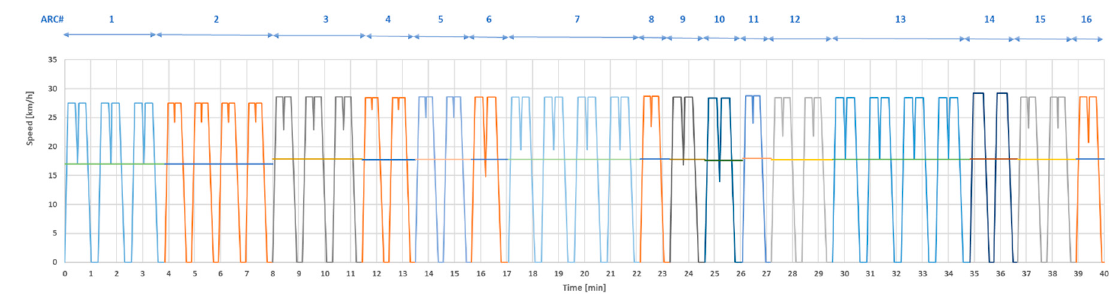
Figure 3. Energy equivalent reconstruction of the LINEA90 in the Rome mission profile.